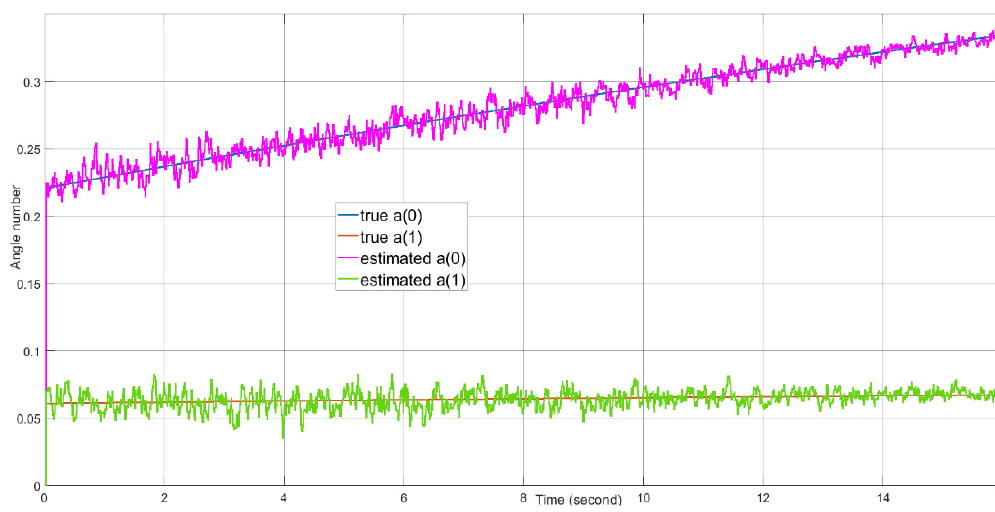
Table 3. Measured RMS tracking errors.